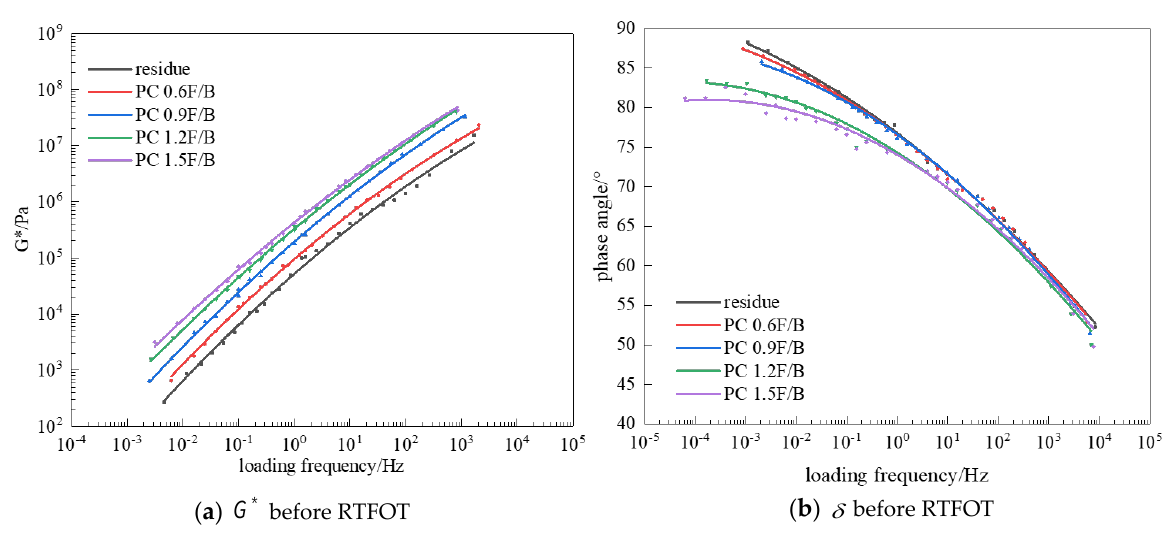
Figure 9. Frequency sweep test results of coal gangue powder emulsified asphalt mastics.